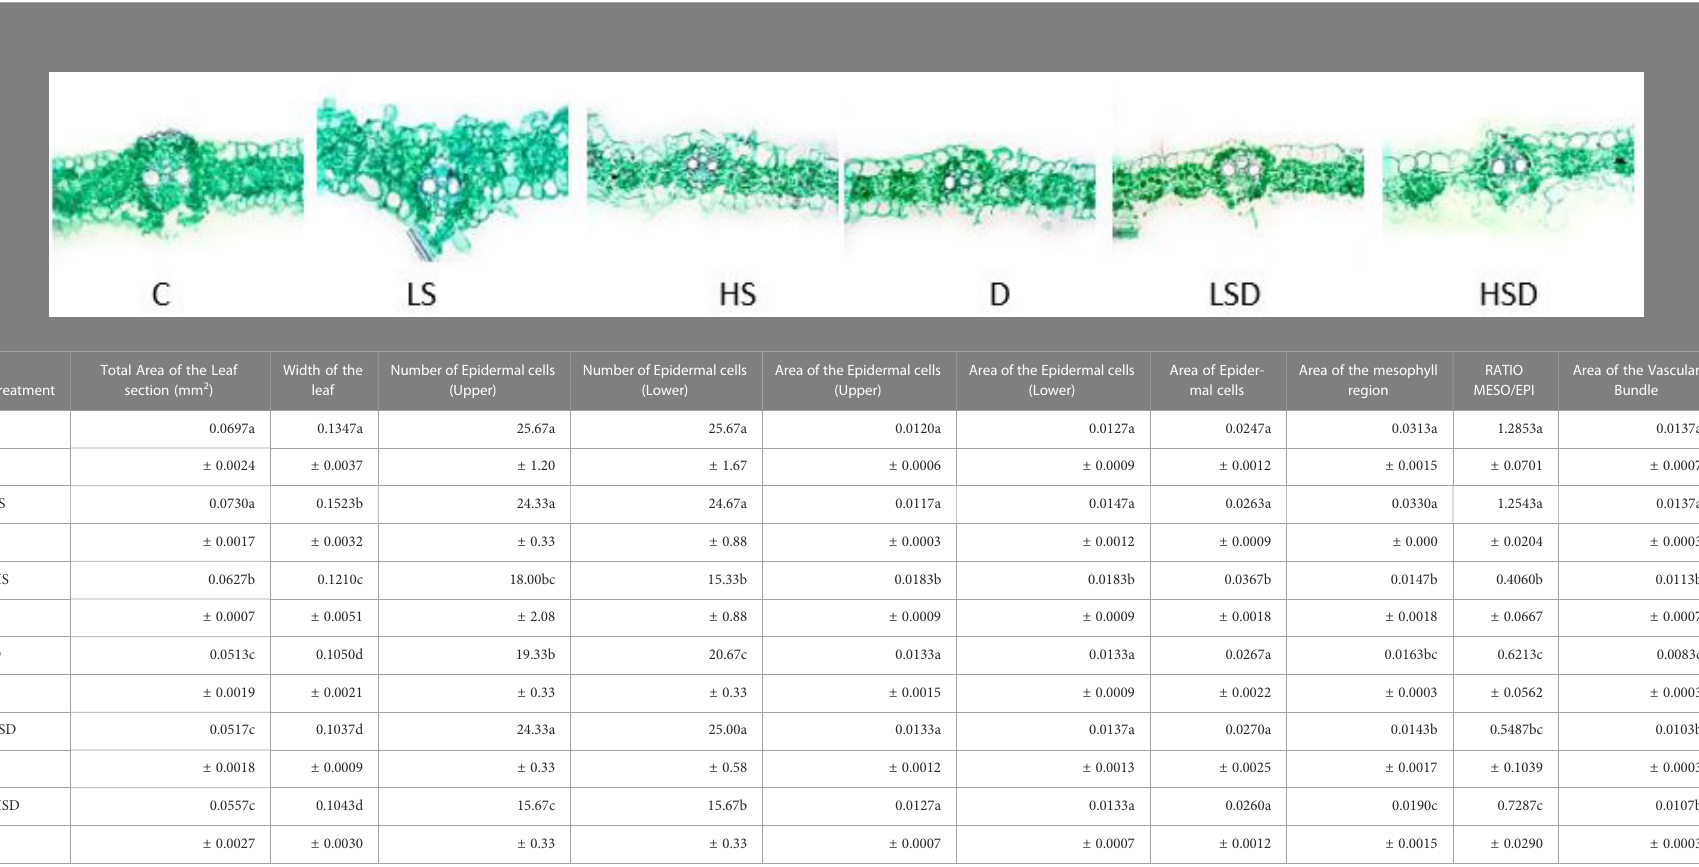
TABLE 3 The effect of salt (0, 100, 300 mM NaCl; abbreviated as C, LS, and HS respectively), drought (D) and combination of both (abbreviated as LSD and HSD) on anatomical parameters of the leaf of Panicum antidotale .